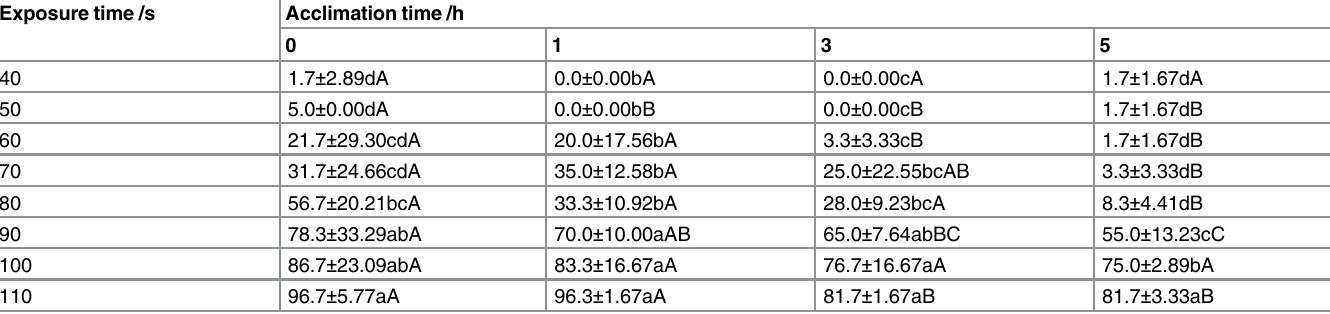
Table 7. The effect of acclimation to sublethal high temperature on mortality (%) of S . zeamais exposed to 55°C. Exposure time